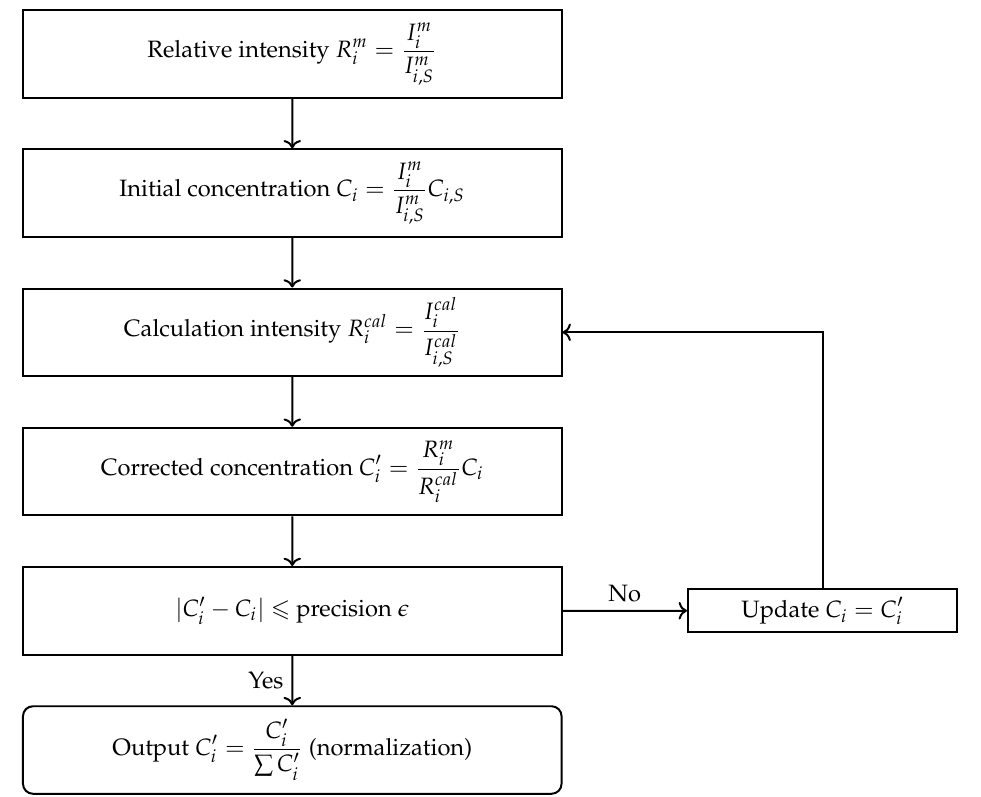
Figure 10. Flow chart depicting the Fundamental Parameter Method for determination of elemental concentrations from APXS